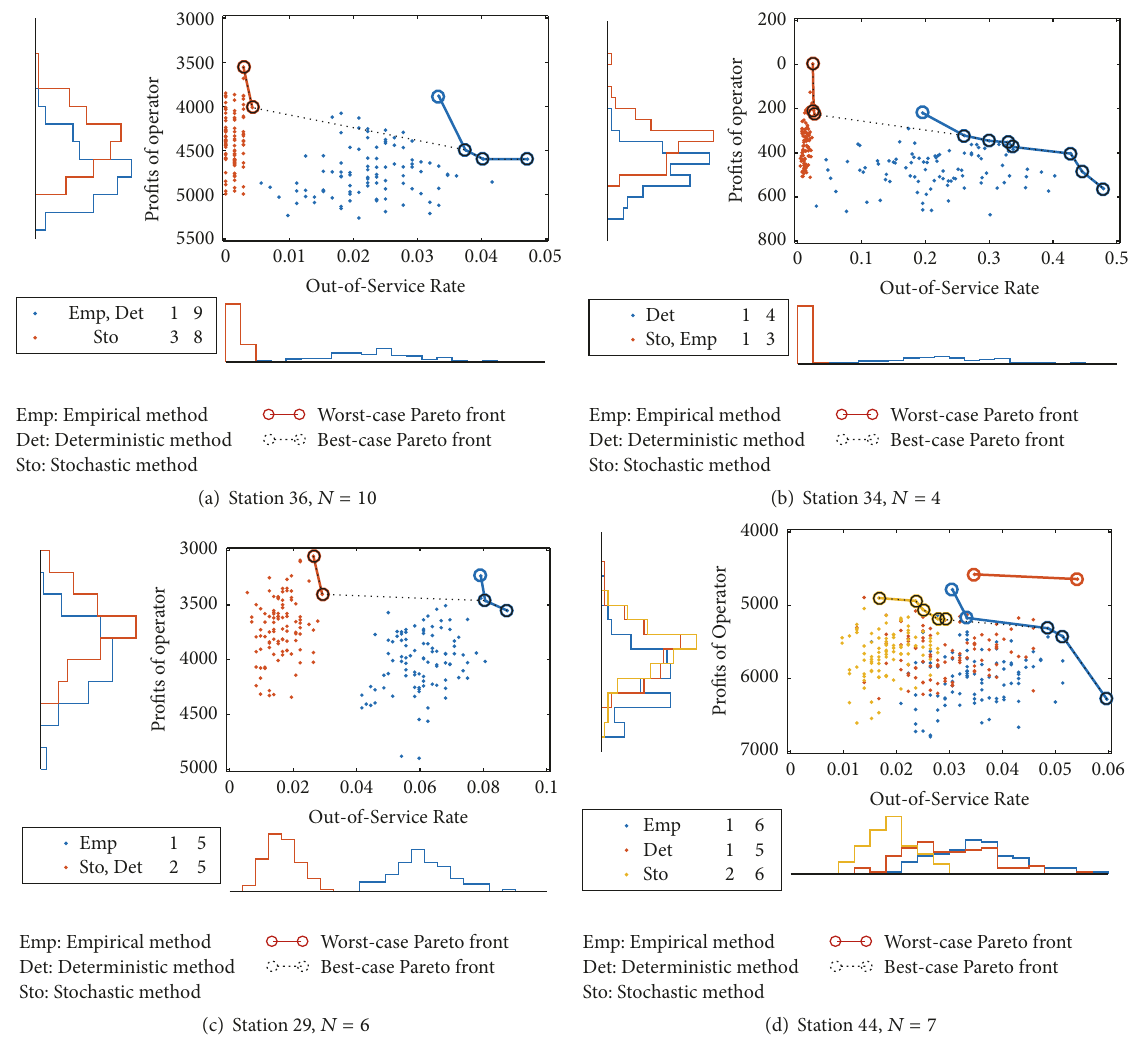
Figure 6: Comparison of the profit among the three methods.